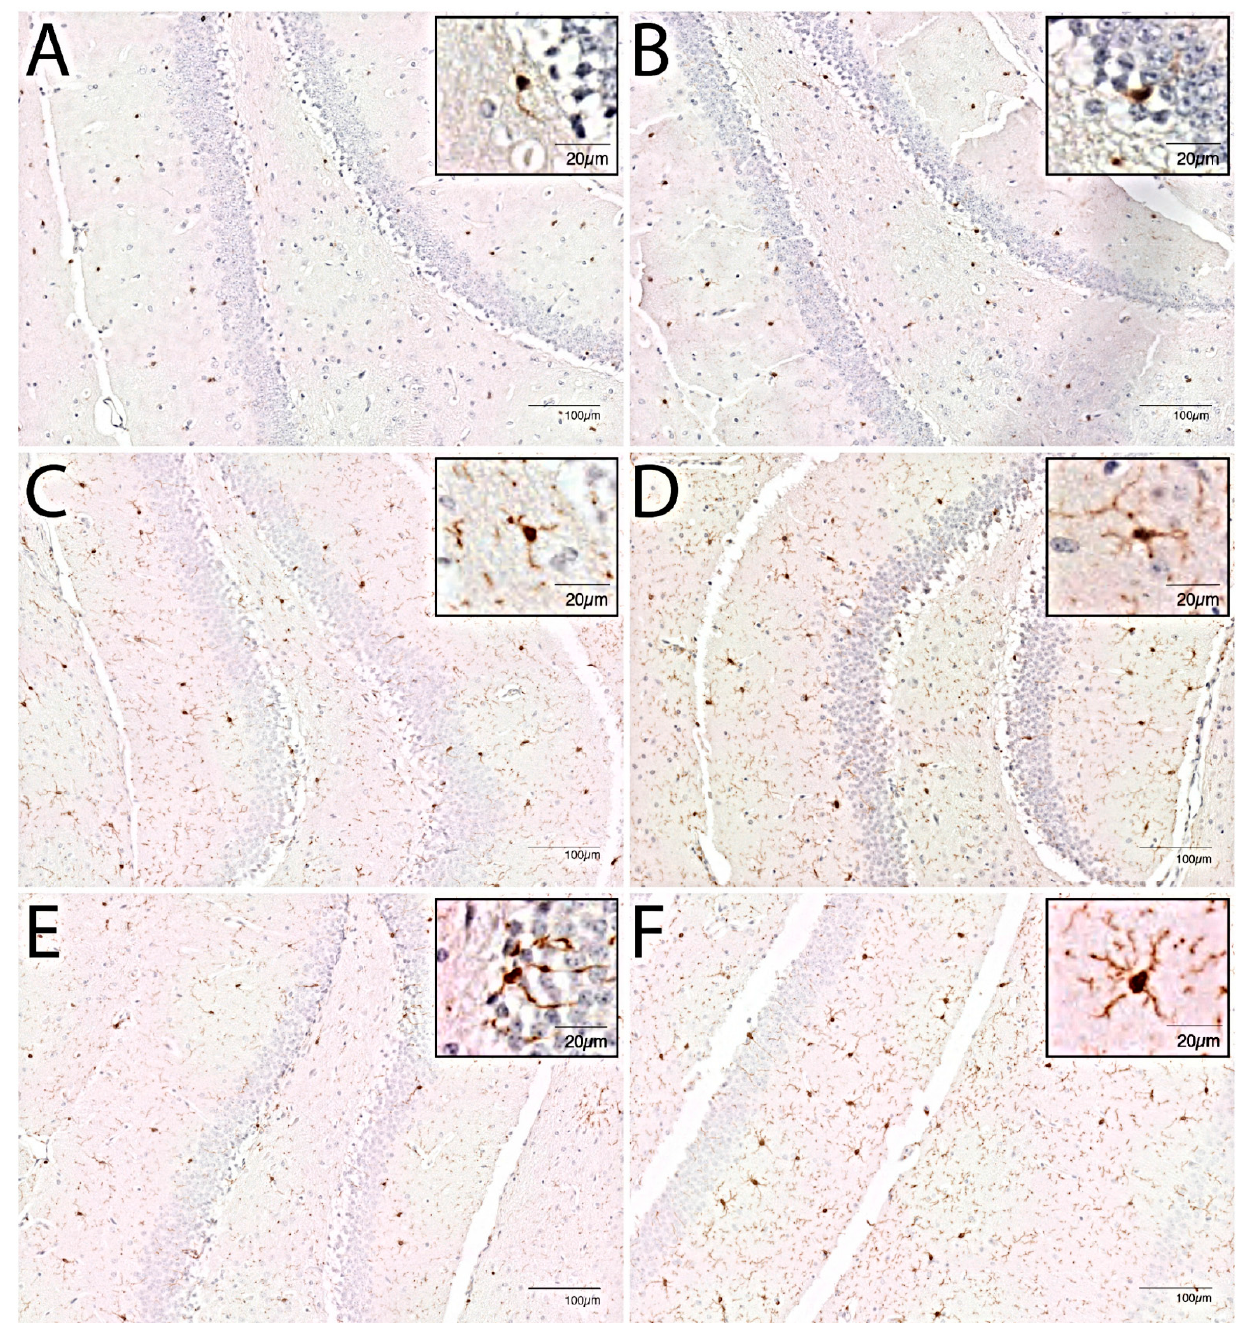
Figure 2. Representative images of immunohistochemical staining with Iba-1 antibody of hippocampus region for young control mice given NaCl and ceftriaxone, sacrificed at day 7 ( A ), middle-aged control mice given NaCl and ceftriaxone, sacrificed at day 7 ( B ), young infected mice given E. coli and ceftriaxone, sacrificed at day 3 ( C ), middle-aged infected mice given E. coli and ceftriaxone, sacrificed at day 3 ( D ), young infected mice given E. coli and ceftriaxone, sacrificed at day 7 ( E ), and middle-aged infected mice given E. coli and ceftriaxone, sacrificed at day 7 ( F